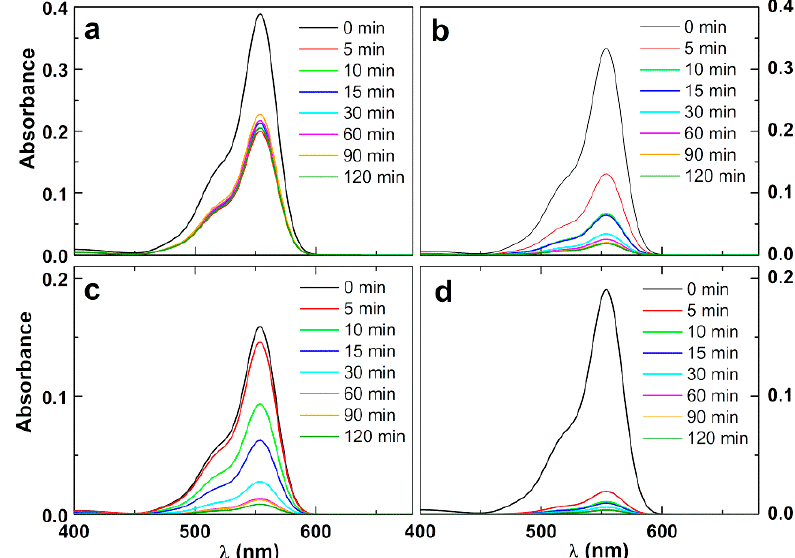
Figure 8. Photodegradation assays of solutions of the dye Rhodamine B (40 mg / L) by silver-decorated zinc / calcium ferrite nanoparticles (NPs), at various concentrations: absorption spectra of Rhodamine B solution at several irradiation times. ( a ) 2 mg / mL of Ag-coated calcined NPs; ( b ) 2 mg / mL of Ag-coated non-calcined NPs; ( c ) 3 mg / mL of Ag-coated calcined NPs; ( d ) 4 mg / mL of Ag-coated calcined NPs.